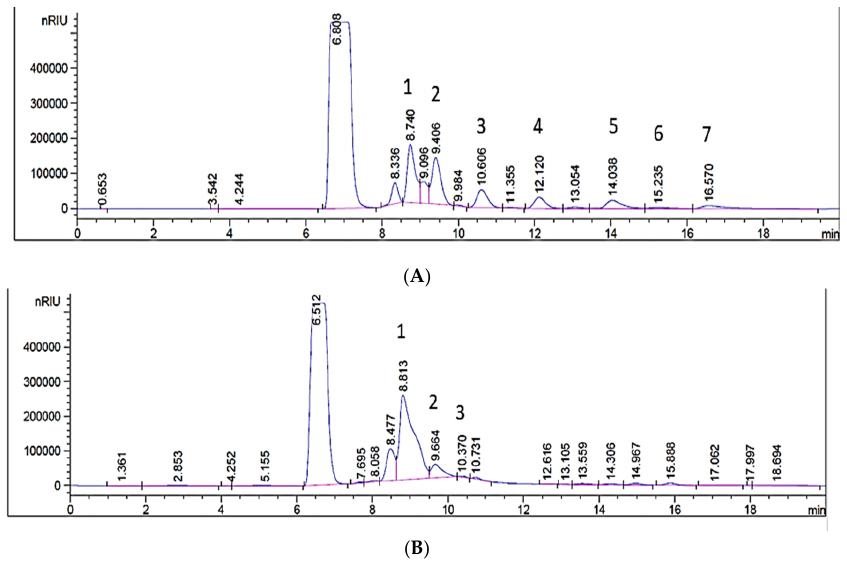
Figure 4. HPLC chromatogram of the TOFAs. Before UC ( A ): (7) Palmitic acid; (6) Palmitoleic acid; (5) Oleic acid; (4) Stearic acid; (1) LA; (3) ALA; (2) GLA. After UC ( B ): (1) LA; (2) ALA; (3) GLA. Table 3. HPLC RT of TOFAs before and after UC.